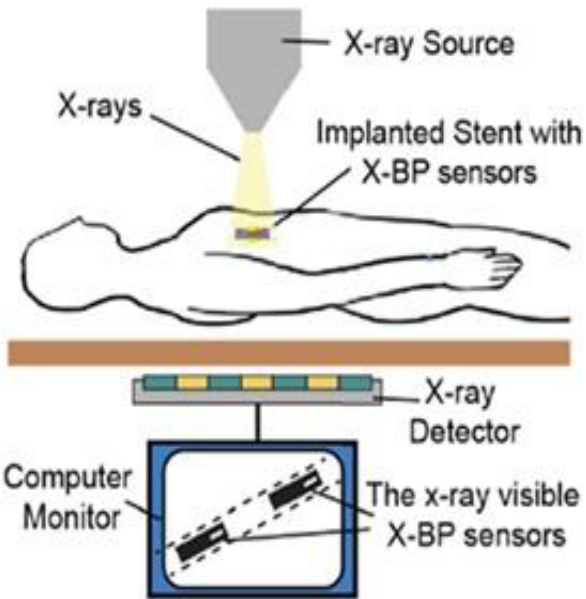
Figure 5. X-ray-based pressure-sensing technology for monitoring restenosis non-invasively. Reproduced with permission [81], copyright 2020, IEEE.